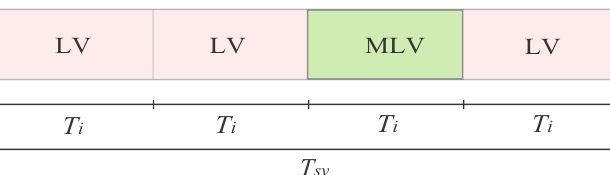
Figure 5. Timing diagram for VV4